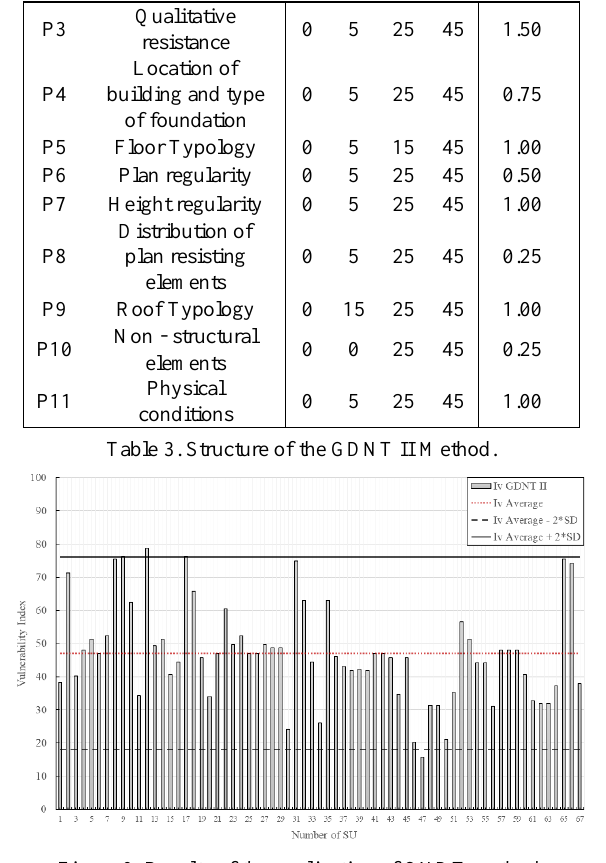
Figure 9. Results of the application of GNDT method.